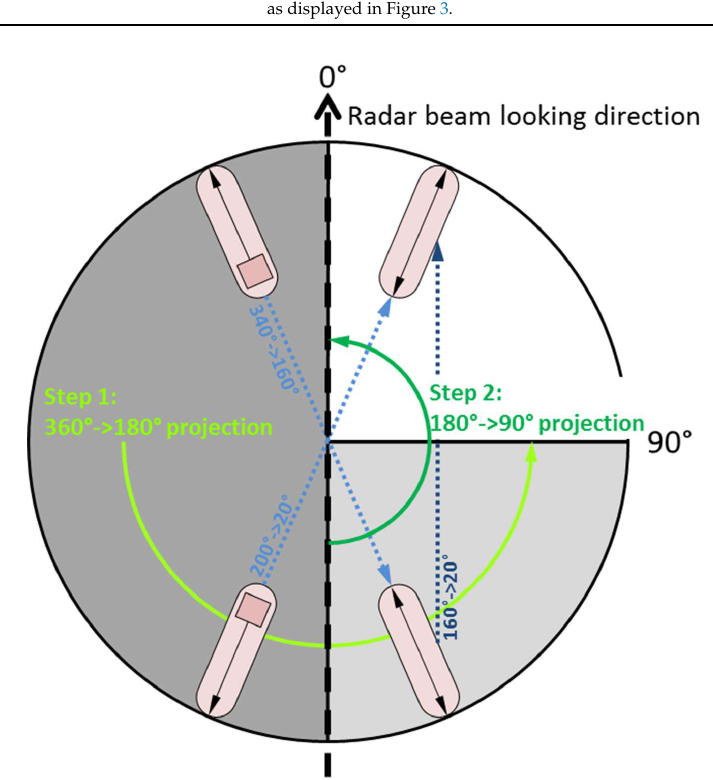
Figure 3. Example for a projection of a ship’s heading from 0°–360° down to 0°–90°. The same projection has been applied to all influencing parameters measured in degrees. Table 1. List of the nine influencing parameters considered in the detectability model along with a description and the value range, in which all samples in the training dataset lie; also a default parameter setting used for the plots in Section 3 is provided.